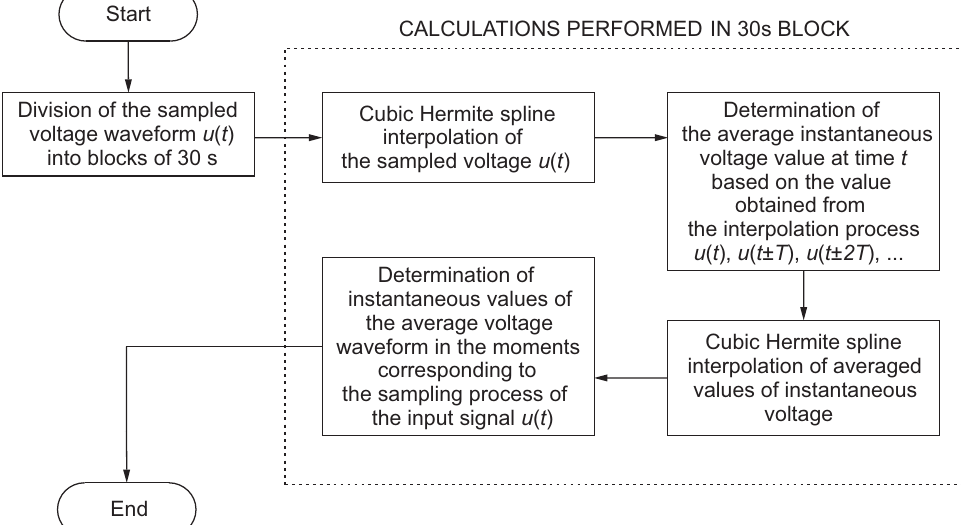
Figure 2. Algorithm for approximating the modulating signal using the estimated carrier signal